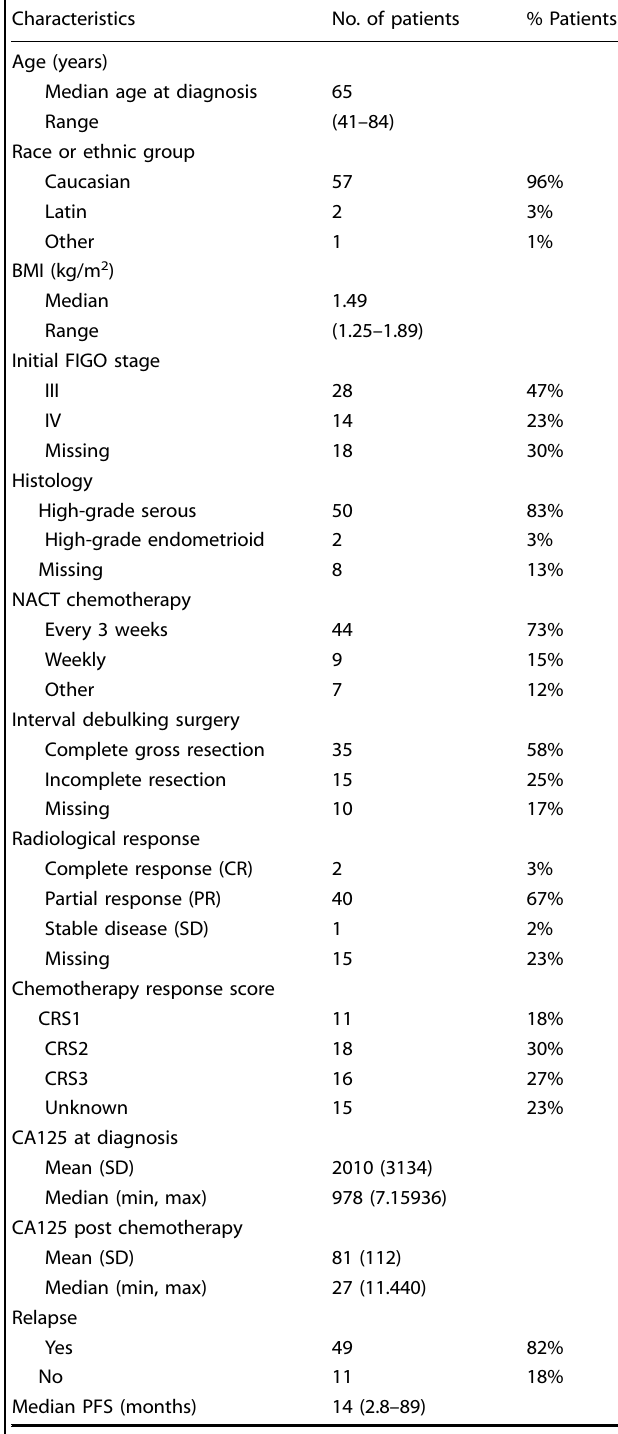
Table 1. Characteristics of the patient and sample